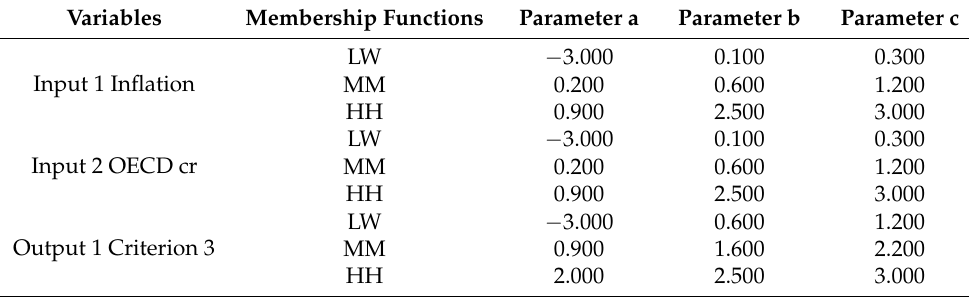
Table 14. Third Type-1 FIS: Input-Output parameters.